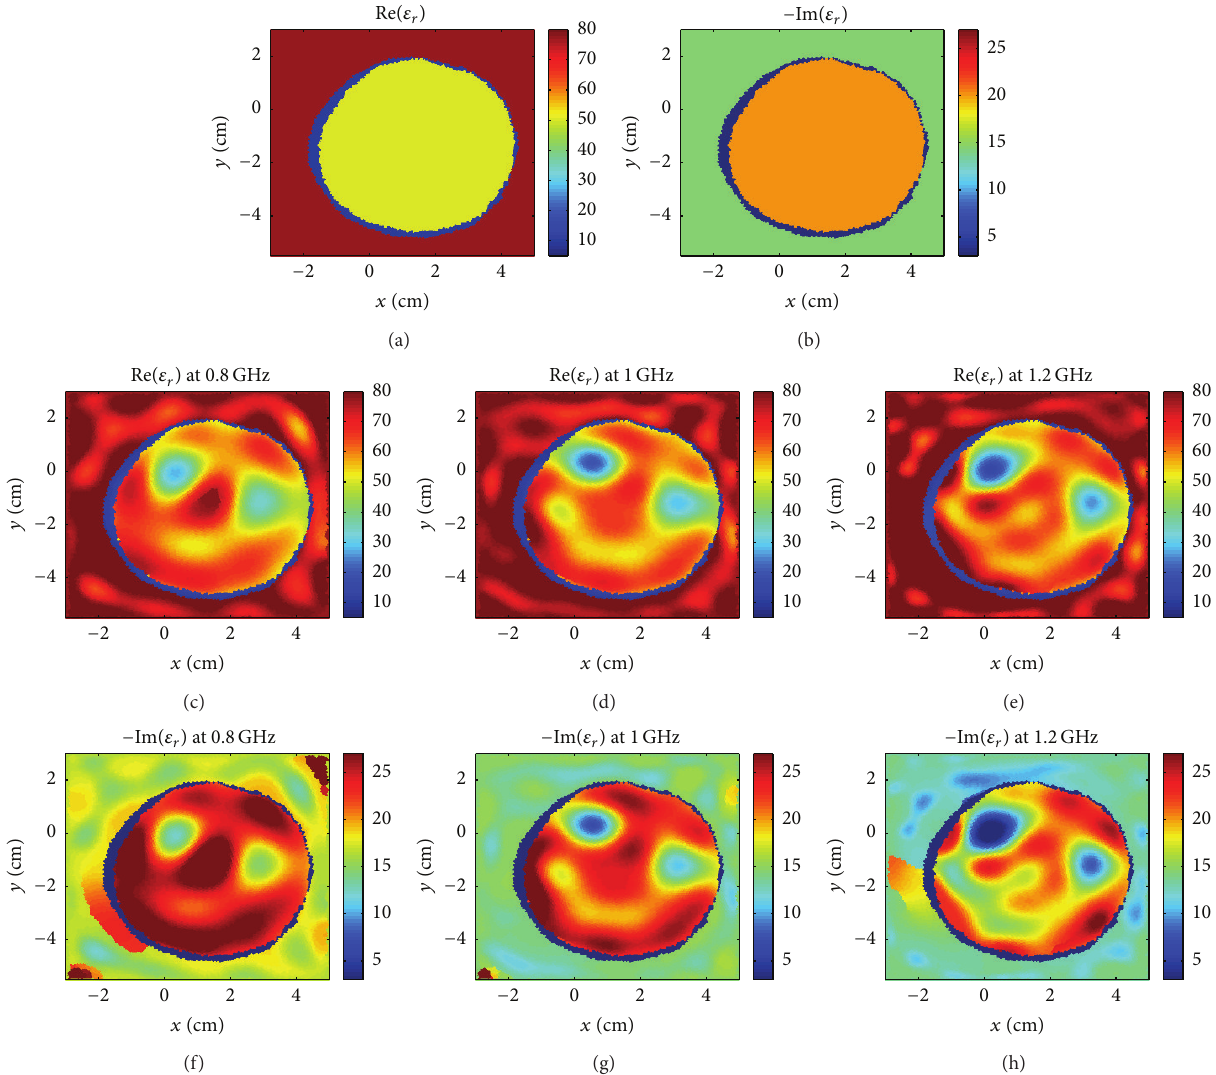
Figure 10: Volunteer 1: (a)-(b) prior information. The reconstruction when prior information is used as inhomogeneous background at (c), (f) 0.8 GHz, (d), (g) 1GHz, and (e), (h) 1.2GHz.